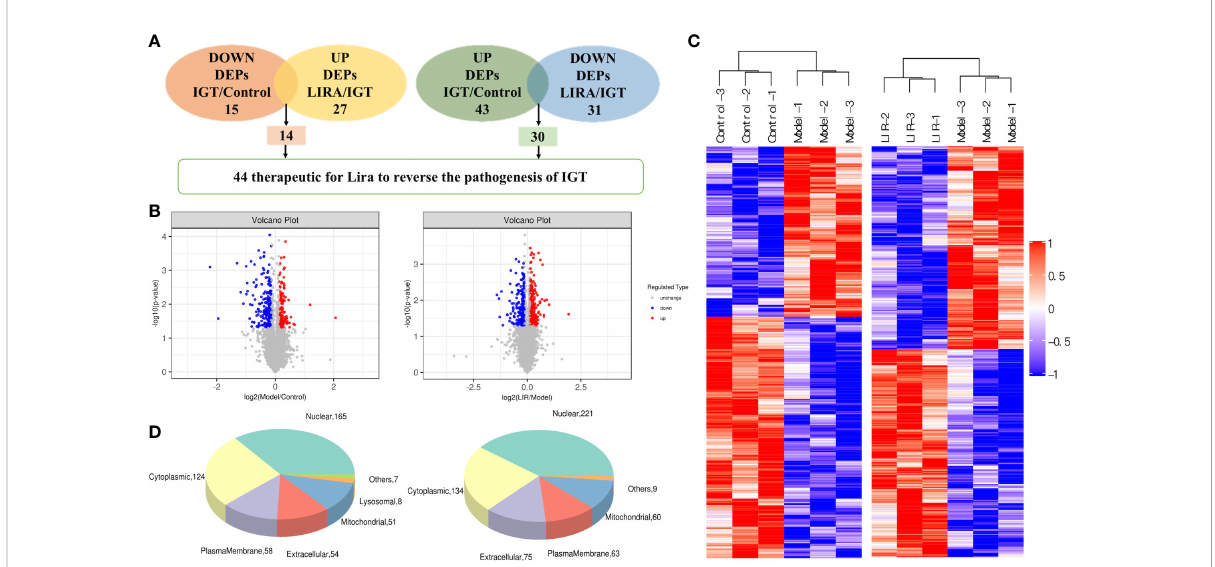
FIGURE 5 (A) The number of differentially expressed proteins among three groups (n=3). (B) Volcano plots of signi fi cantly differentially expressed protein targets among the three groups. dots in the volcano plot represent differential proteins, red represents up-regulation, green represents down- regulation, and black represents differential proteins that did not meet the screening conditions and were excluded. The left fi gure represents Model/Control differential protein screening, and the right fi gure represents LIRA/Model differential protein screening. (C) Heat map of signi fi cantly differentially expressed proteins between groups. the horizontal axis represents the sample number, the vertical axis represents the differential protein, the color represents the relative expression of the differential protein, and clustering analysis was performed on the differential proteins with similar expression. (D) The subcellular localization of differentially expressed proteins among the three groups. The left panel showed the subcellular localization of Model/Control differential proteins; the right panel showed the subcellular localization of LIRA/ Model differential